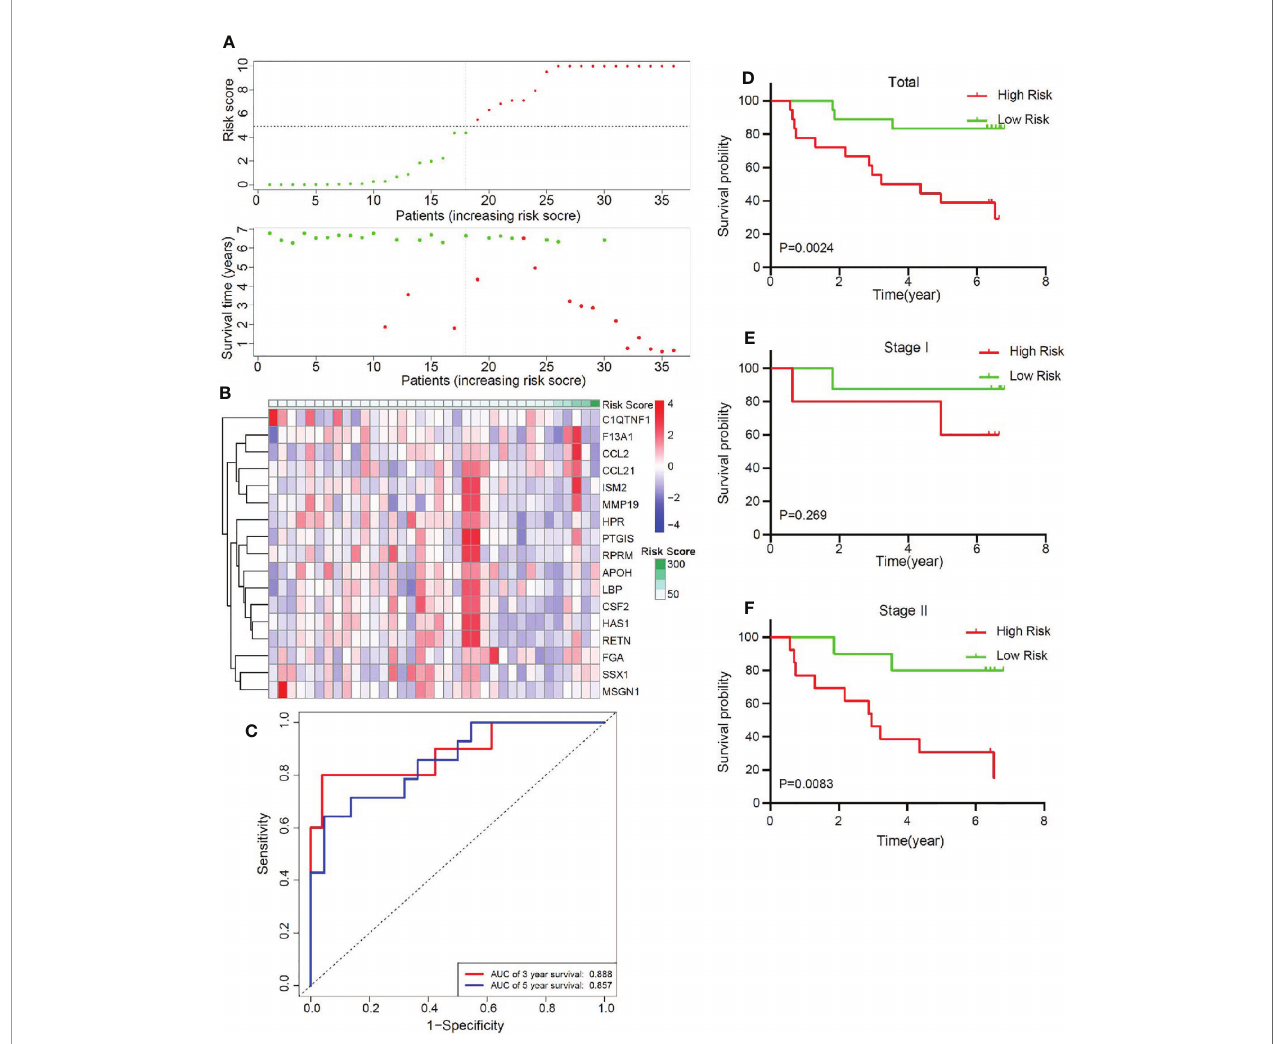
FIGURE 7 | Validation of the prognostic value of the key immune-related gene signature based on a group of 36 frozen tissues from early stage LUSC patients. (A) The distribution of risk score and survival status. (B) Distribution of speci fi c gene expression based on risk score. (C) ROC curves of these key genes to predict death risk at 3 and 5 years. (D) Comparison of overall survival of all patients with early stage LUSC between high risk and low risk. (E, F) Kaplan – Meier curves of patients with stage I and stage II LUSC based on risk